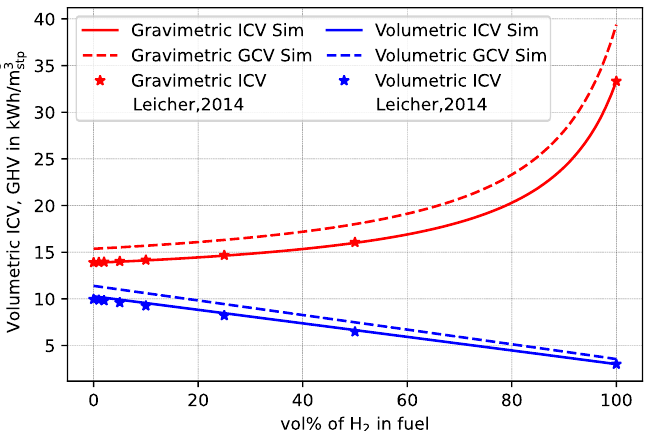
Figure 7. Predicted changes in mass- and volume-related gross calorific values (GCV) and inferior calorific (ICV) with increasing H 2 vol% in the fuel mixture, compared to literature data given in Leicher, 2014